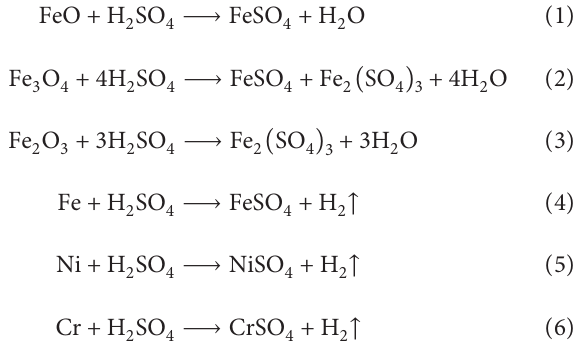
Figure 9: Dynamic pickling rate in 300gL − 1 H 75 ° C under different rotary speed conditions.